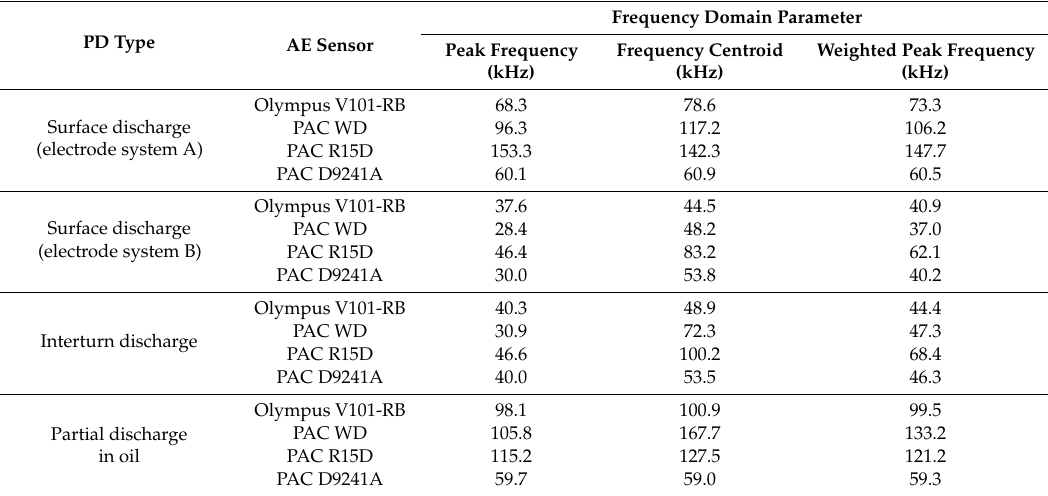
Table 3. Frequency-domain parameters determined on the basis of the average PSD of AE pulses emitted by the investigated forms of partial